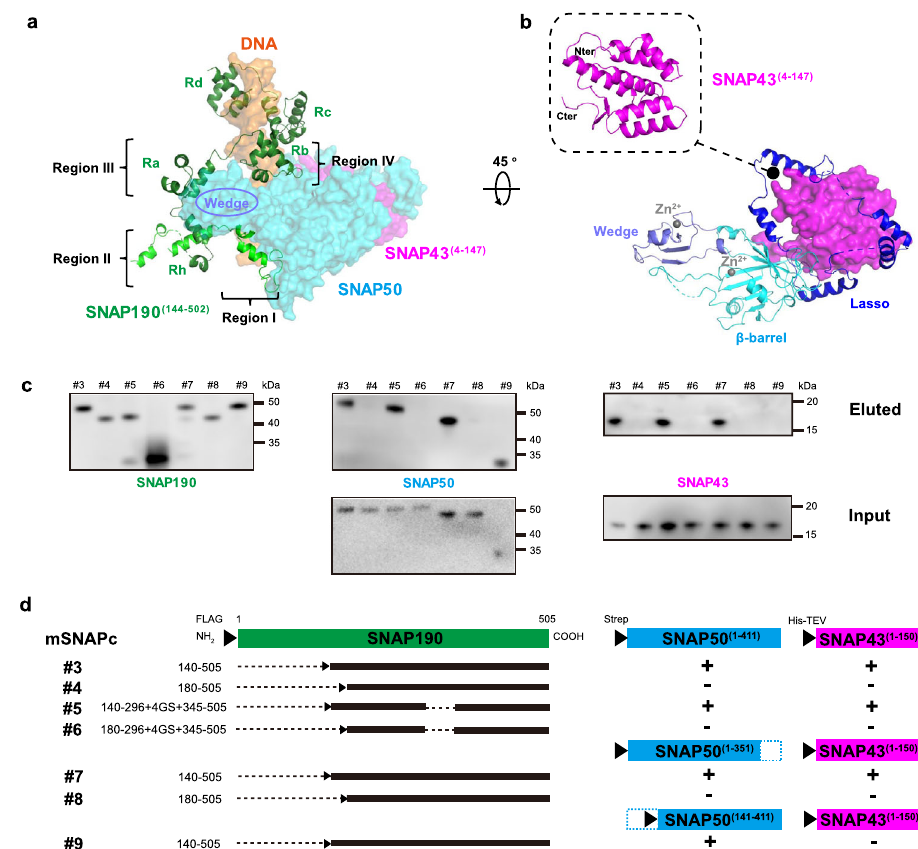
Fig.2|Mini-SNAPcassemblesina “ wrap-around ” mode.a Domainorganizations ofSNAP190 (144-505) .FourandahalfMYBrepeats(Rh,Ra,Rb,Rc,andRd)areshownin dark green. Four regions of SNAP190 potentially interacting with SNAP50 are indicated. b The experimental structures of SNAP50 and SNAP43 (4-147) . The lasso domain, the β -barrel domain and the Wedge domain are shown in blue, cyan, and light blue, respectively. Two zinc atoms are labeled as gray dots. The NTD of